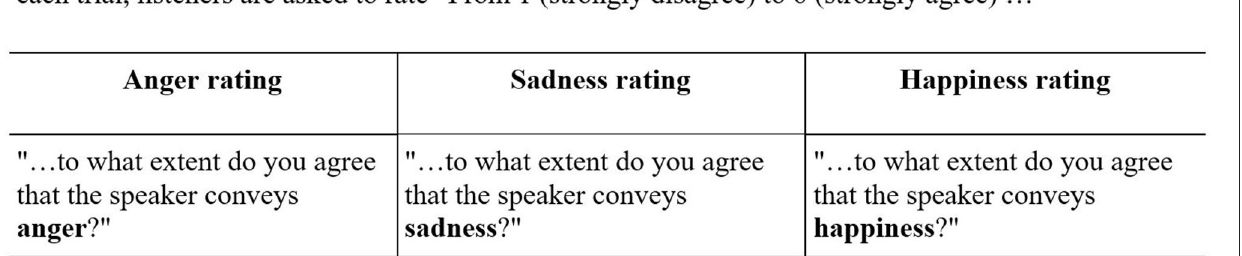
FIGURE 2 | General design of T-RES: Rating tasks and rating blocks.